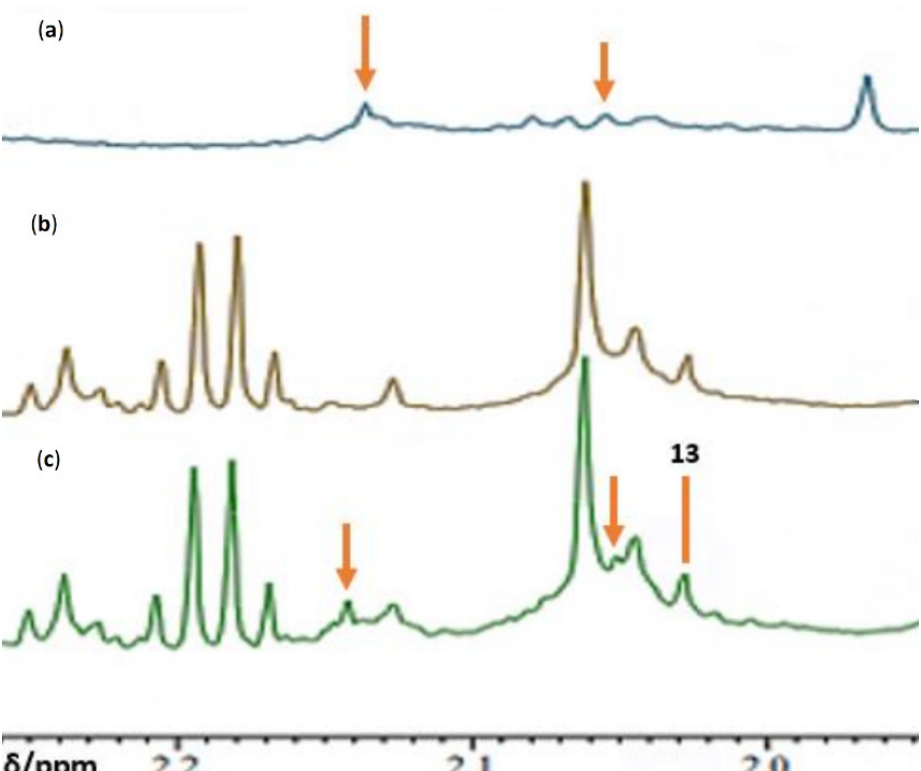
Figure 6. 1 H NMR Evaluation of the Treatment of WMSS Samples with the Enzyme Hyaluronidase. Partial (1.50–2.26 ppm regions of) 600 MHz WASTED-II 1 H NMR spectra of ( a ) an aqueous solution containing a commercially available hyaluronidase enzyme preparation (4167 units/mL in aqueous solution containing 8.33% ( v / v ) 2 2H 2 O); ( b ) a typical untreated WMSS specimen; ( c ), as (b), but treated with 4167 units/mL of the hyaluronidase preparation (both control and hyaluronidase-treated saliva samples also contained 8.33% ( v / v ) 2 2H 2 O). Both untreated and treated saliva samples were equilibrated for a duration of 8.00 h. at pH 6.50 and 25 °C prior to 1 H NMR analysis. Assignment abbreviations: as Table 1. The arrows in ( c ) indicate resonances arising from 1 H NMR-active contaminants introduced from the added enzyme preparation. Spectra were recorded on a Jeol JNM-ECZ600R/S1 600 MHz spectrometer operating at frequency of 600.17 MHz for 1 H (probe operating temperature 25 °C).